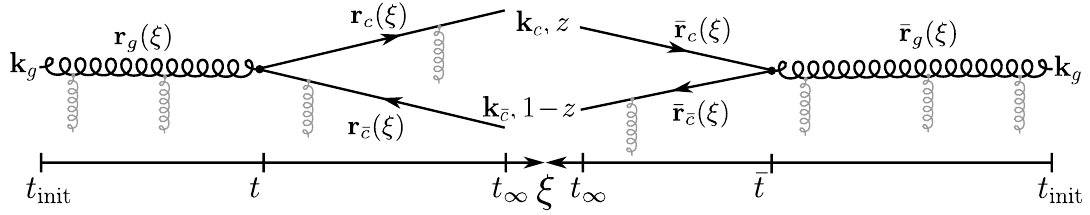
and k and longitudinal c ¯ c